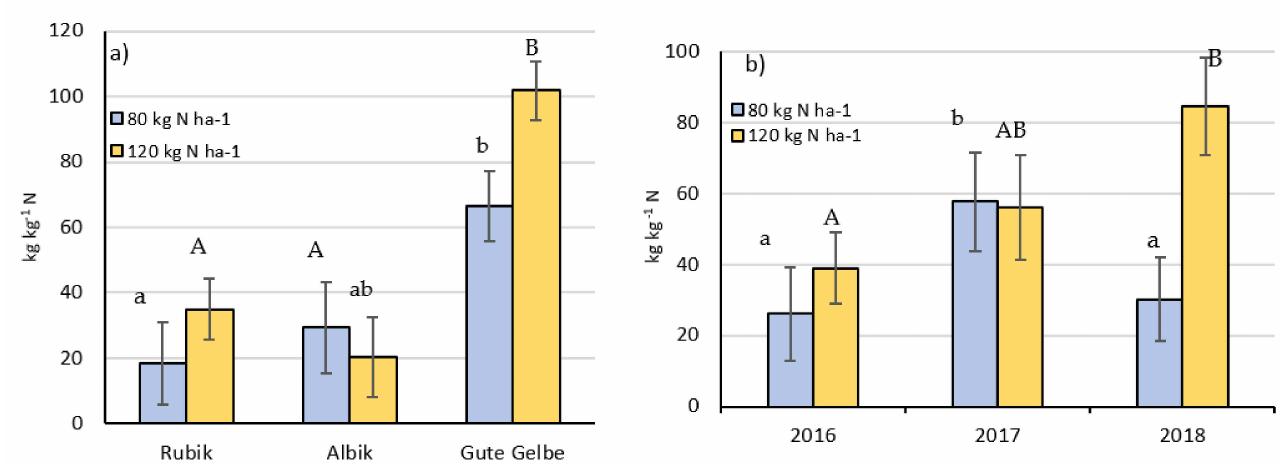
Figure 3. Agronomic N-use efficiency (AE) for cultivars ( a ) and years of the study ( b )—(average ± SE, lower case letters for N rate of 80 kg N ha − 1 ; upper case letters for N rate of 120 kg N ha − 1 ; bars followed by the same letters do not differ significantly at p <